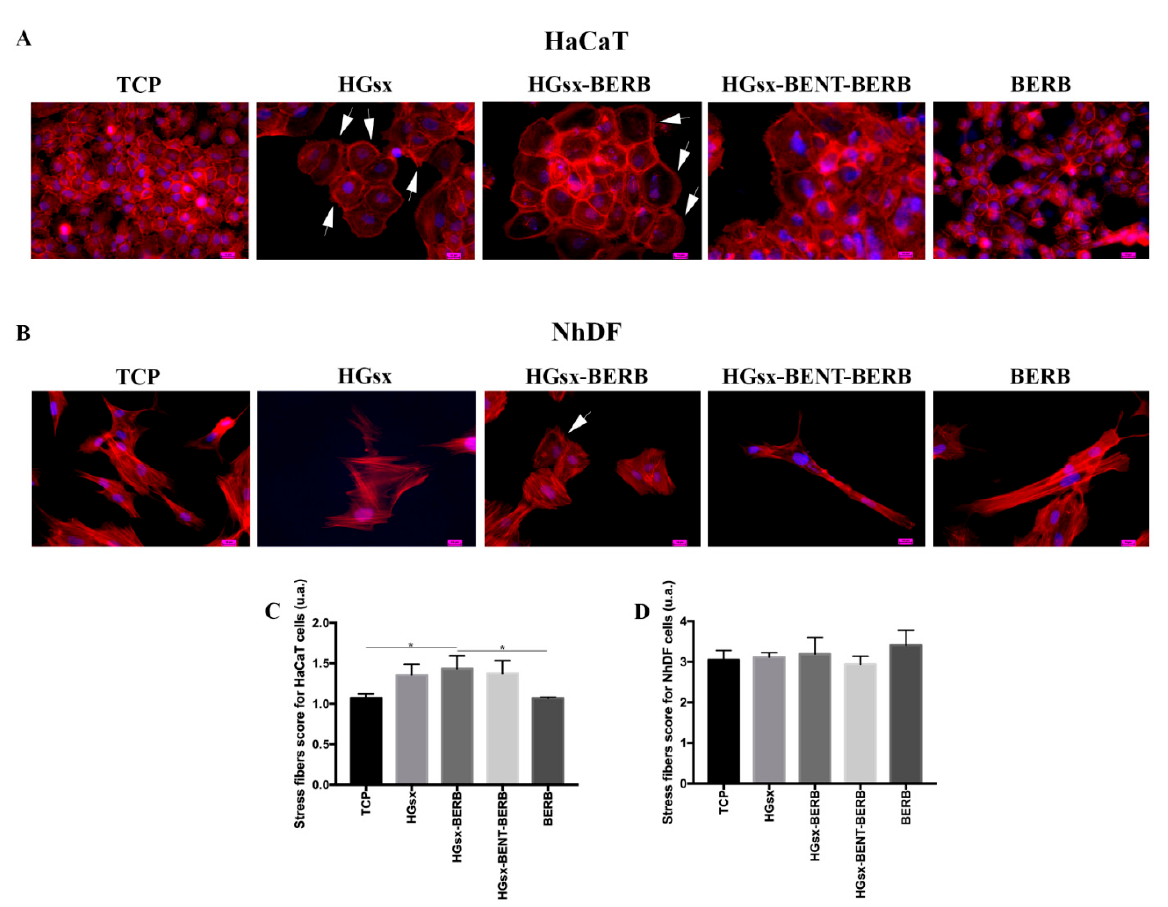
Figure 5. Morphological and stress fibers evaluations. Representative images of actin cytoskeleton immunofluorescence detection in HaCaT ( A ) and NhDF ( B ) cultured in the different conditions. 40× magnification. Scale bar 10 µm. White arrows indicate migration features in cells: lamellipodia and filopodia in HaCaT cells ( A ) and actin polarization at the cellular front in NhDF cells ( B ). ( C ) Stress fibers score for HaCaT cells: significant differences between TCP and HGsx-BERB, and HGsx-BERB and BERB were found. (* p ≤ 0.05) ( D ) Stress fibers score for NhDF cells.